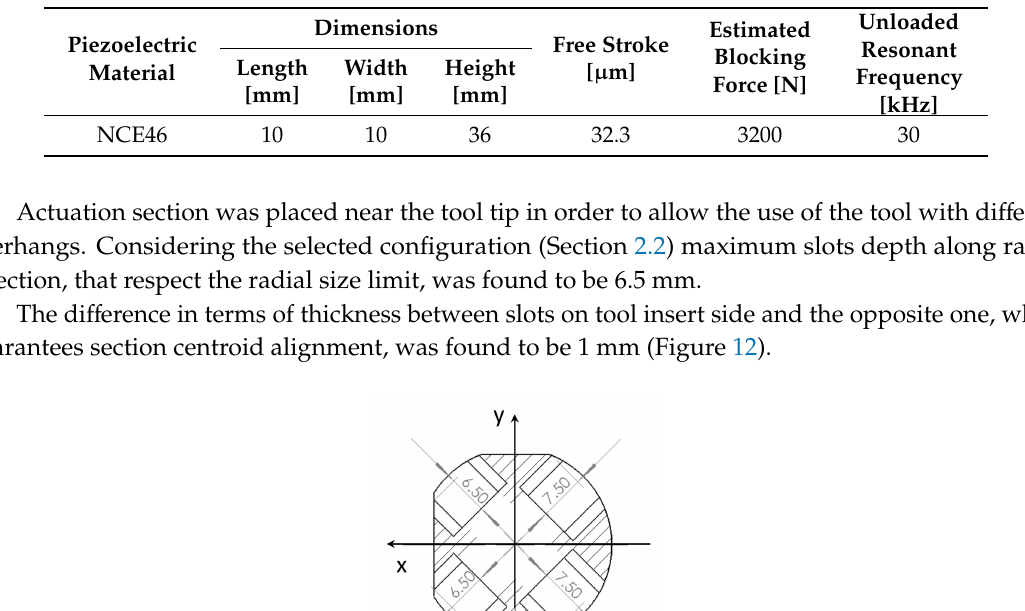
Table 3. Selected actuator characteristics.